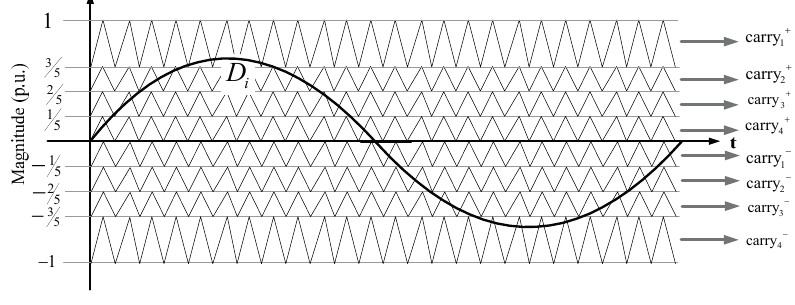
Figure 6. Nine levels SPWM